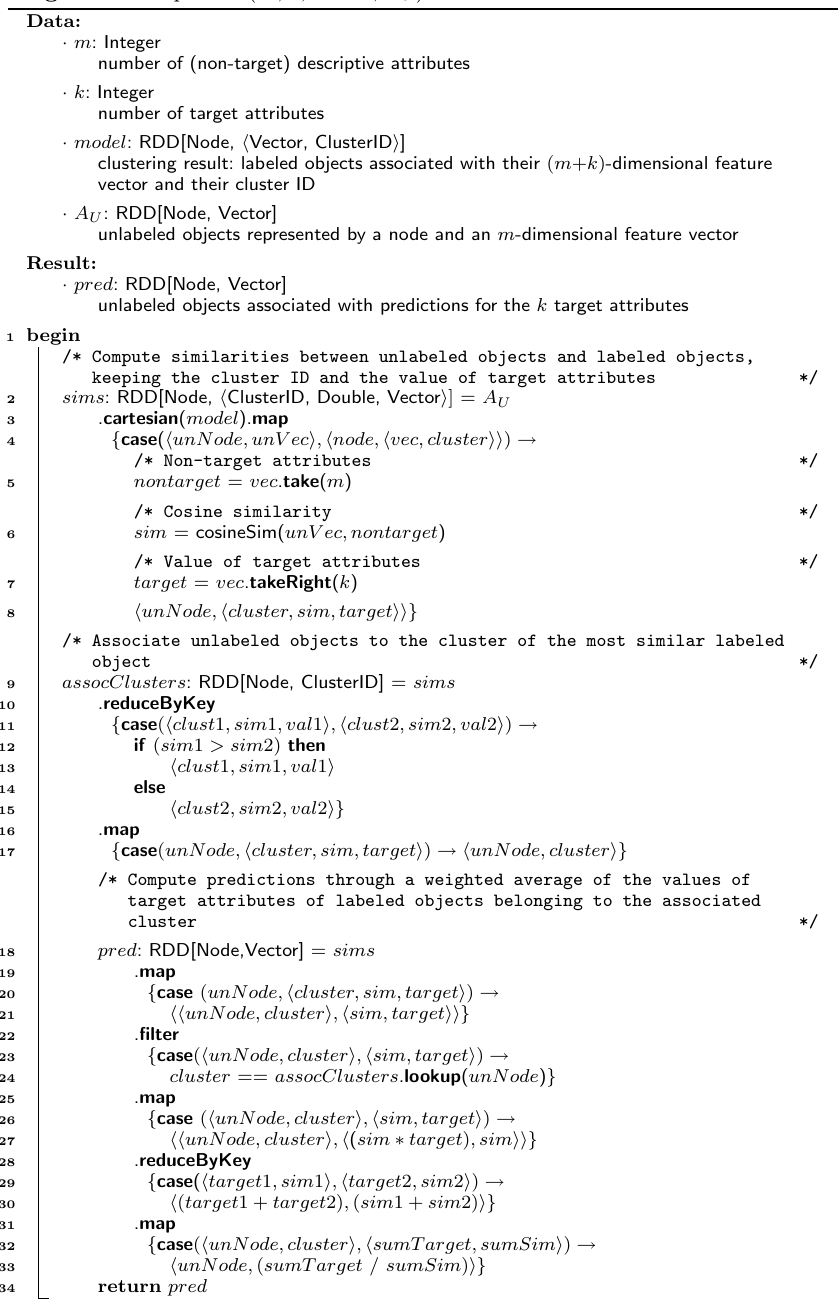
Algorithm 4: predict ( m, k, model, A U